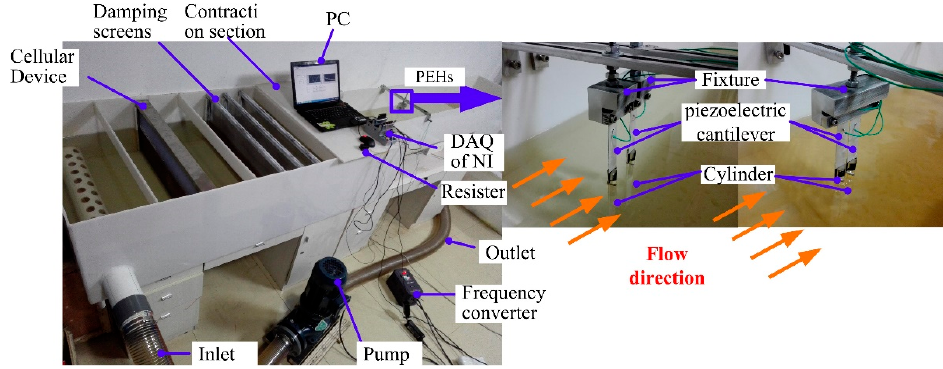
Figure 4. Energy harvesting experimental platform and prototypes of two tandem PEHs.